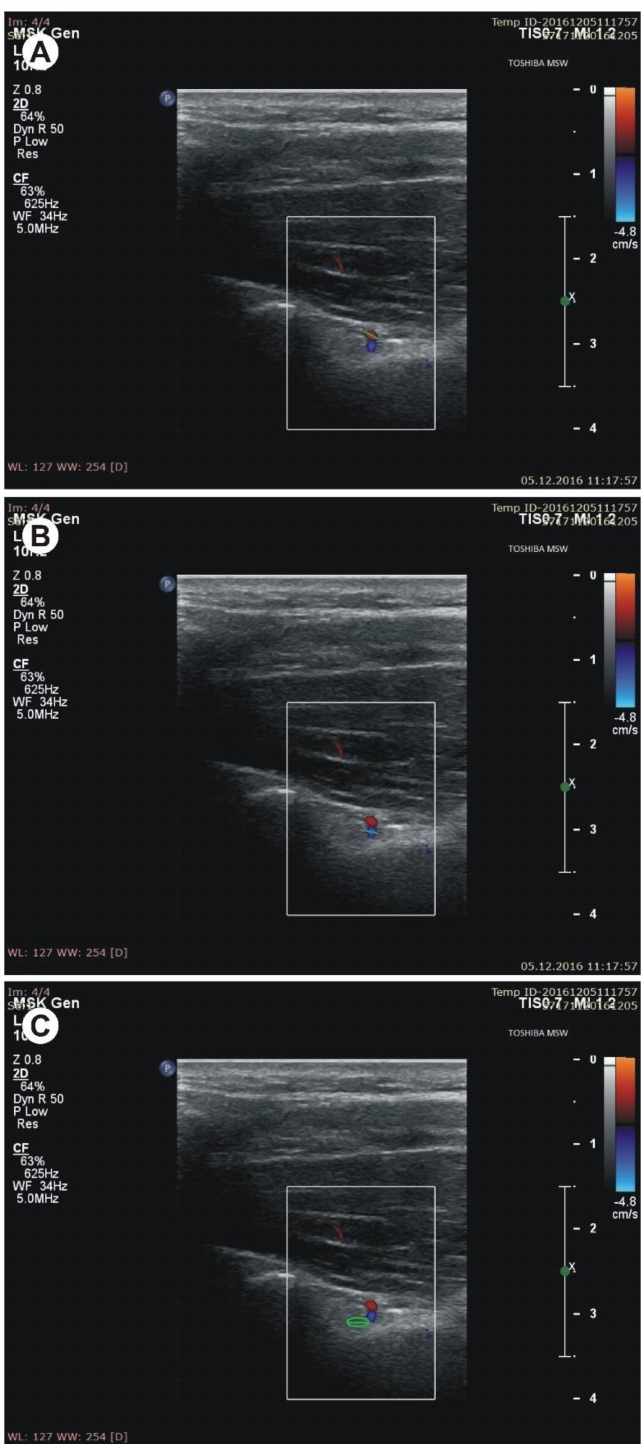
Figure 3. Measurements of structures at the suprascapular notch (SSN) notch region during sonographic examination. ( A ) diameter of the suprascapular artery; ( B ) diameter of the suprascapular vein; ( C ) diameter of the suprascapular